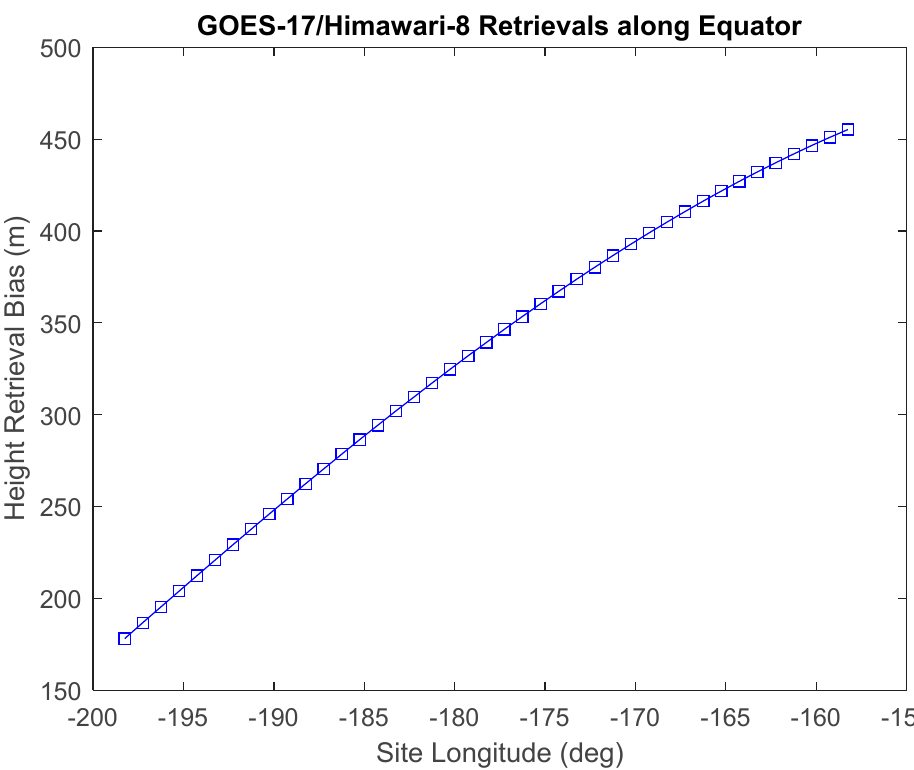
Figure 26. Retrieved height bias grows with the distance from the Himawari-8 SSP along with the elongation of AHI pixels on the ellipsoid. The height bias will grow in proportion with the EW NAV bias, which is a single 0.5 km pixel in this case.